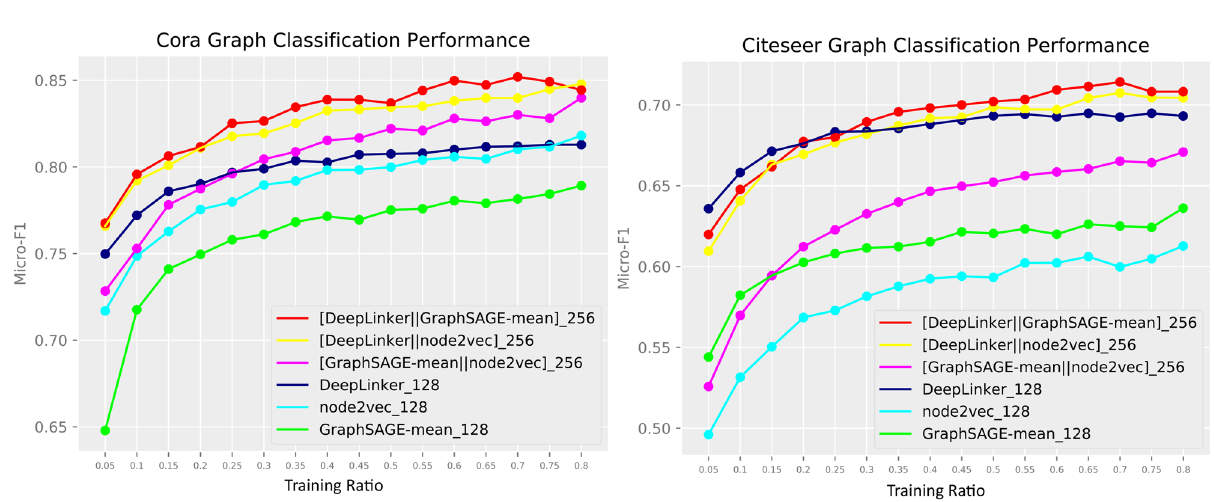
Figure 4. Classification accuracy comparison under different representation learning methods over a variety of training